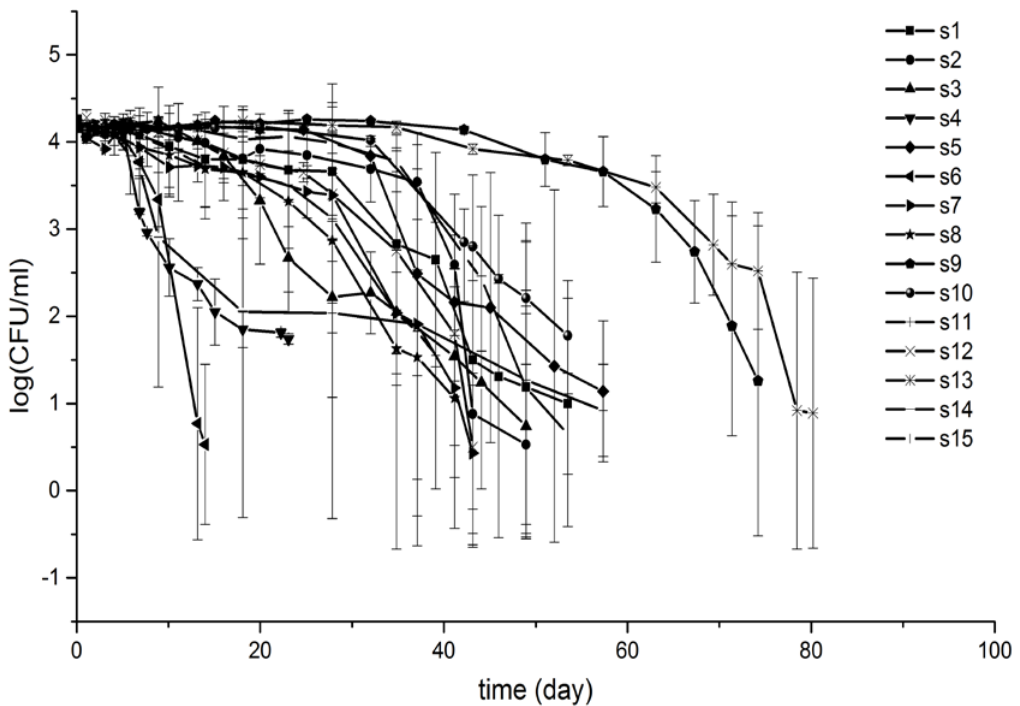
Figure 1. Survival curves of S. Typhimurium in well water samples.